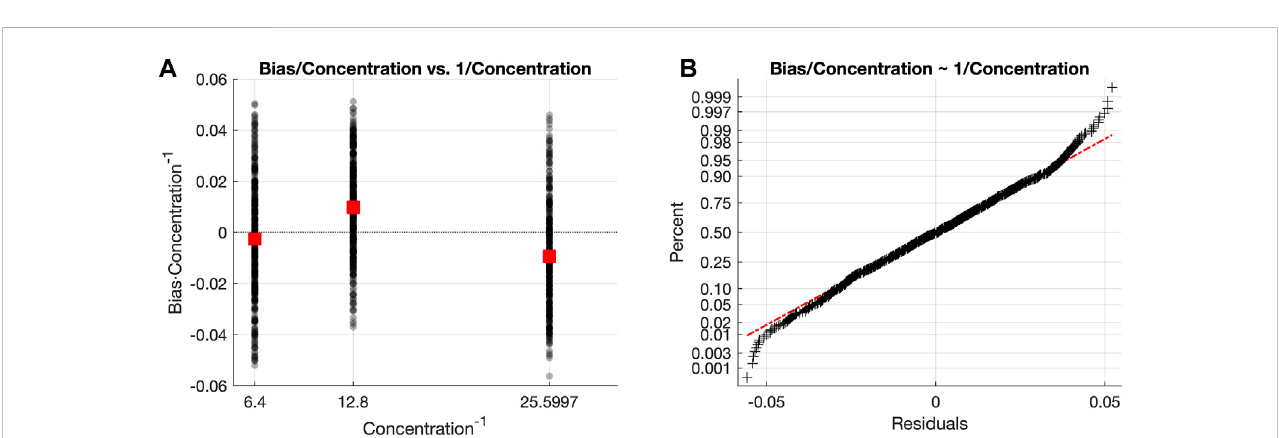
FIGURE 4 (A) Scatter plot of the scaled bias values, where black dots represent every scaled bias value and red squares are the mean scaled bias value for each concentration level. (B) Normal probability plot of the residuals quantifying the uncertainty using the scaling of the residuals (Eq. 12) by the concentration values.Thereddashedlinerepresentstheidealcurvedescribedbyresidualsperfectlyfollowinganormaldistribution.Blackcrossesarethescaledresidualsfor every data point in the Model Building